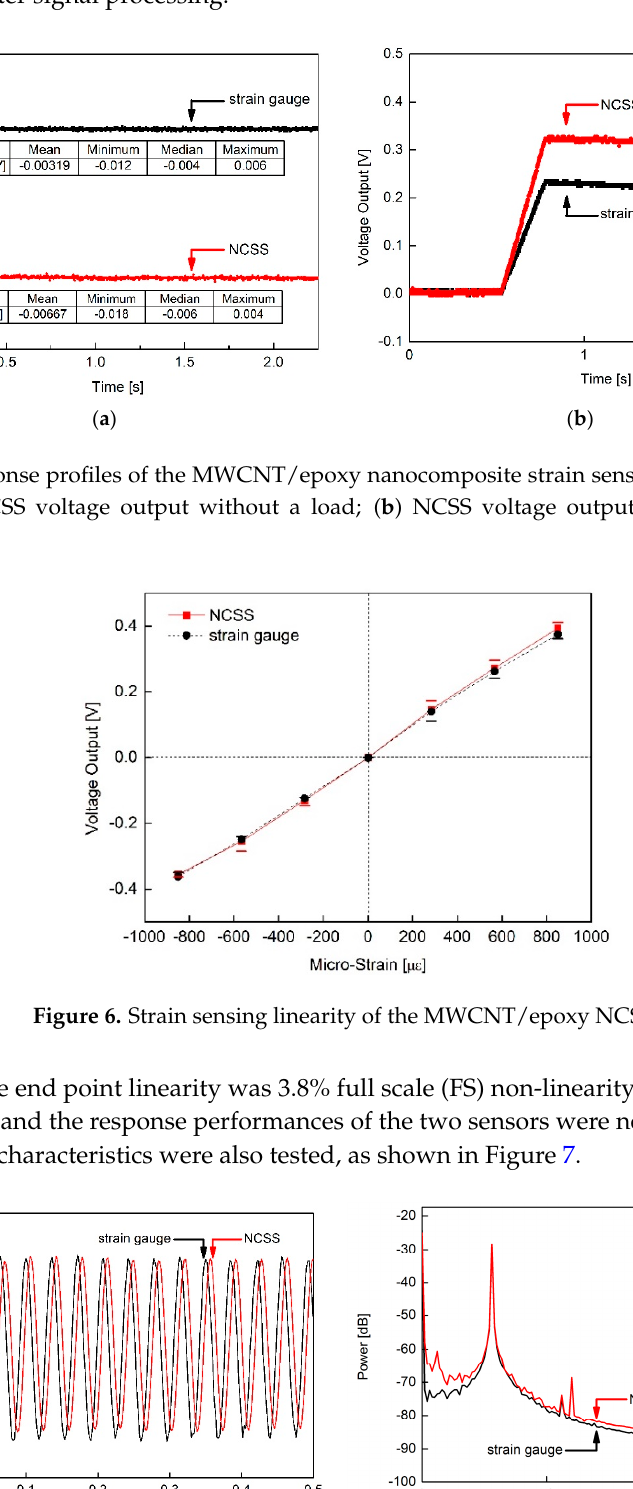
Figure 7. Dynamic characteristics MWCNT/epoxy NCSS; ( a ) voltage output response under 28 Hz excitation and ( b ) NCSS power spectra.